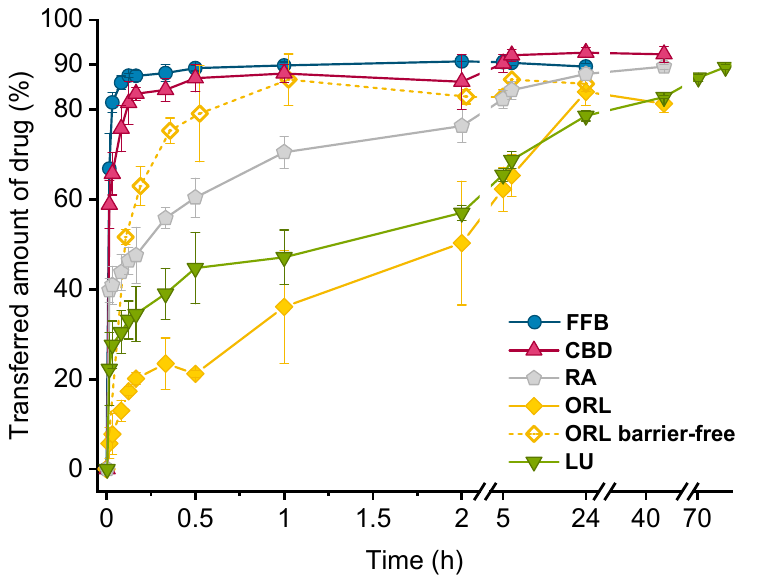
Figure 6. Drug transfer into trimyristin nanoemulsion-containing microgel beads or a rapeseed oil nanoemulsion (barrier-free; dotted line). Each value represents mean ± standard deviation ( n = 3). Abbreviations: FFB = fenofibrate, CBD = cannabidiol, RA = retinyl acetate, ORL = orlistat, LU = lumefantrine.